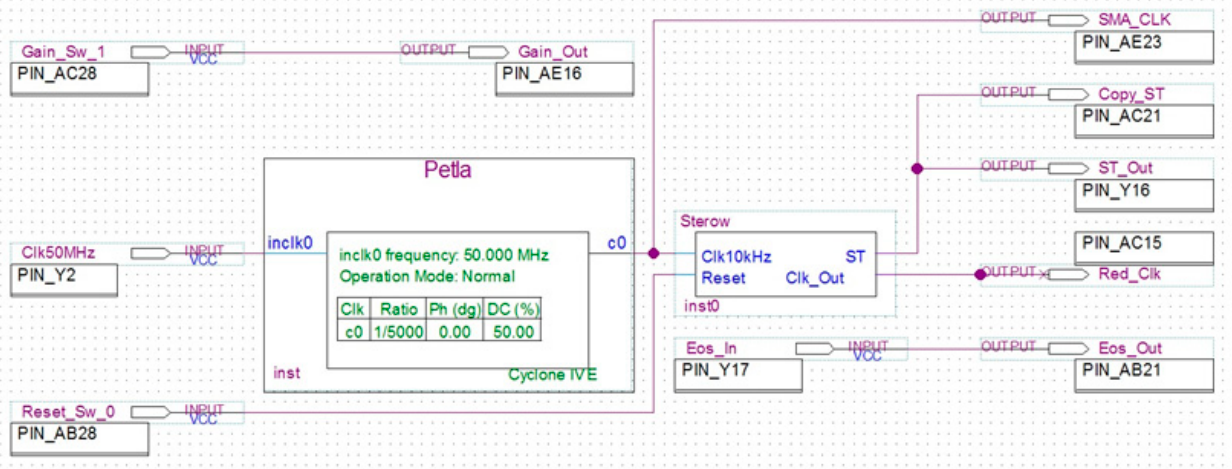
Figure 19. Simulation results of low-pass filter amplitude characteristics.